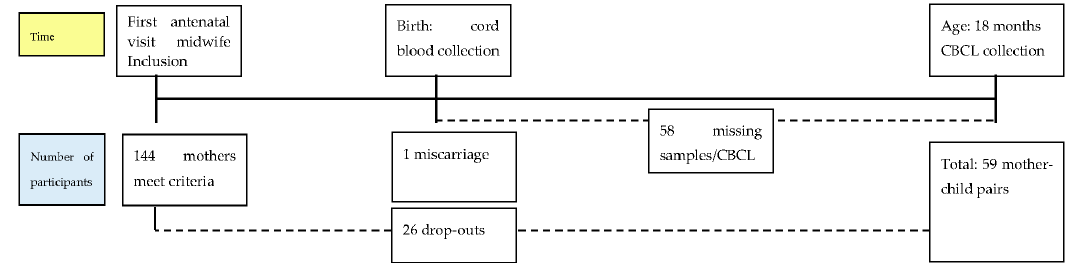
Figure 1. Flow chart of the number of participants and timeline of the study. Table 2. Maternal and CBCL data for the study population.